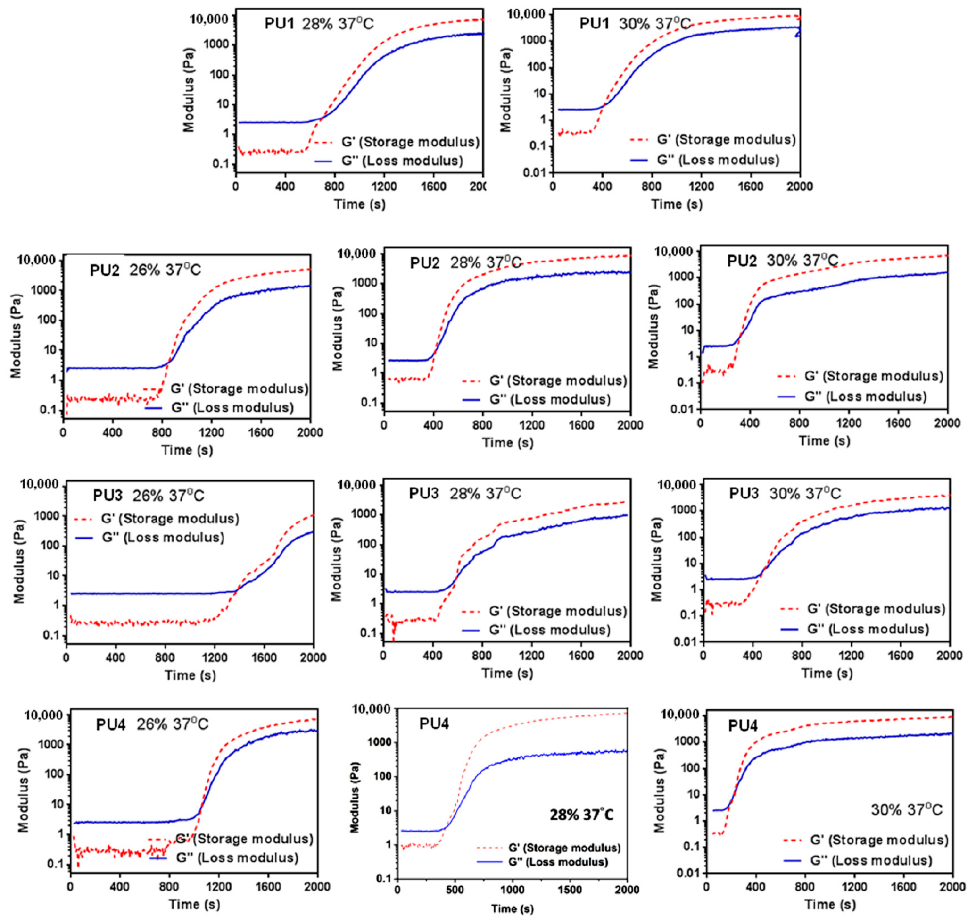
Figure 3. Time-dependent changes of the storage modulus ( G ’) and loss modulus ( G ’’) of PU1, PU2, PU3 and PU4 of different total solid contents after the temperature rises from 25–37 °C.